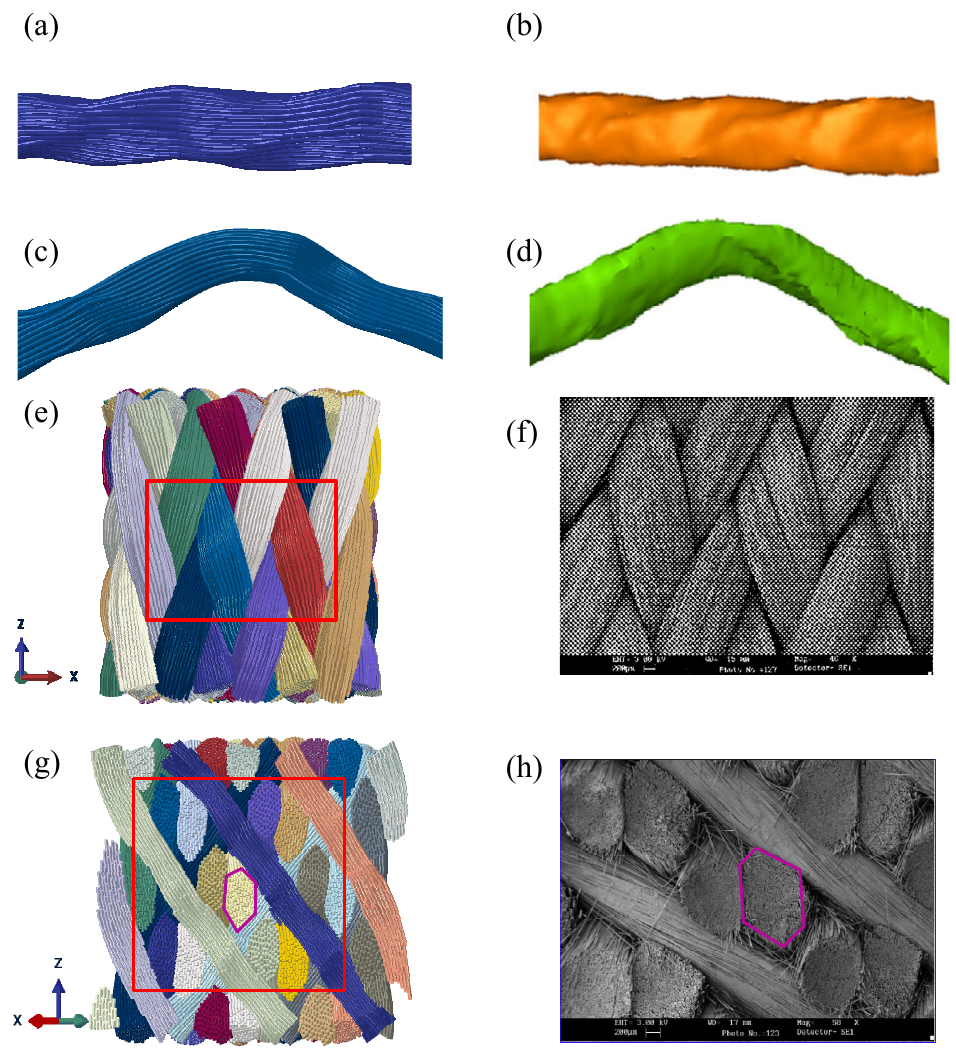
Figure 9. Comparison of the virtual structure and the experimental results: ( a ) the simulation interior yarn, ( b ) the micro-CT interior yarn [13]. Reprinted with permission from [13], Copyright